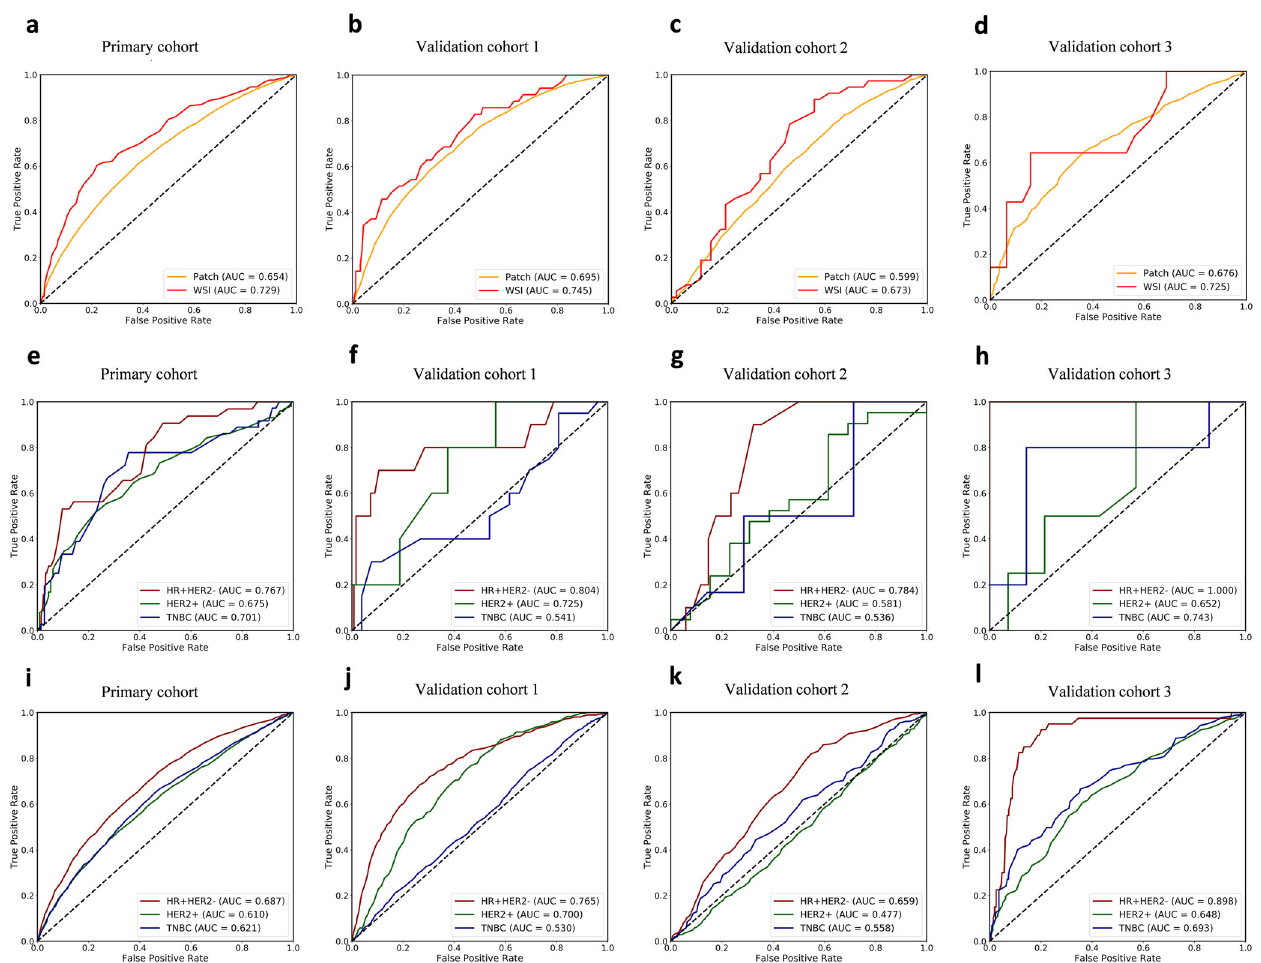
Fig. 3 ROC curves of TS-score in the four hospitals. a – d Show the WSI-level and patch-level performance of TS-score in the total dataset among the four centers; e – h show the WSI-level performance of TS-score in different breast cancer subtypes, and i – l show the patch-level performance of TS-score in different breast cancer